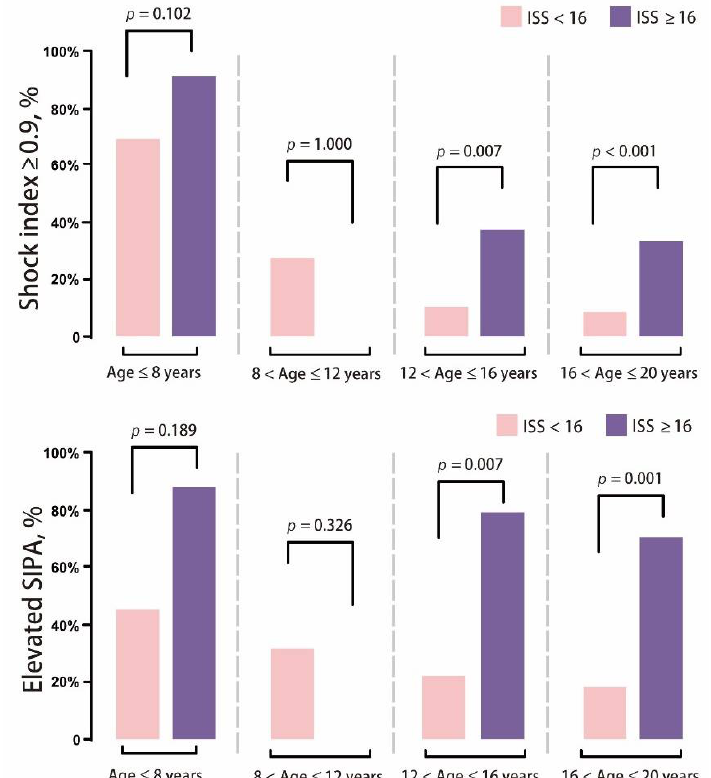
Figure 3. Schematic diagram illustrating the shock index (SI), the percentage of SI ≥ 0.9 and elevated pediatric age-adjusted SI (SIPA) of distribution of high (injury severity score, [ISS] ≥ 16) and low injury (ISS < 16) in different age range.